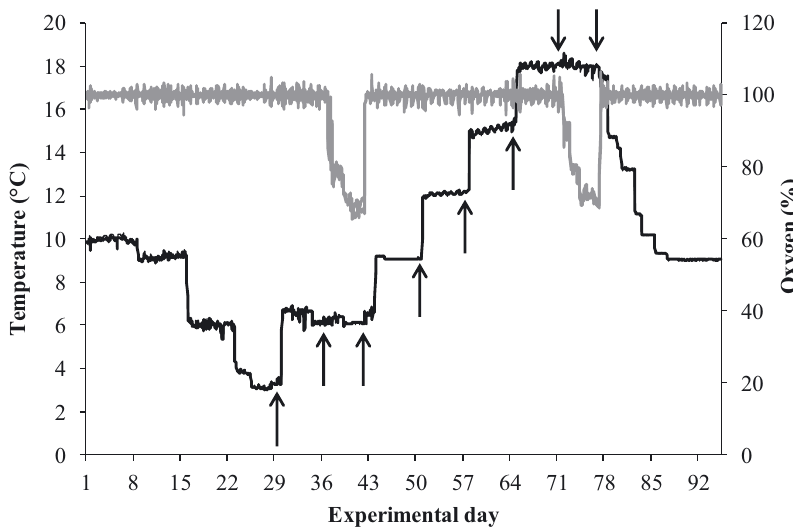
Fig. 1. Water temperature (black line) and water oxygen saturation (grey line; n = 24 measurements per day) in experimental tanks with large diploid and triploid Atlantic salmon Salmo salar in seawater. Arrows indicate the sampling time